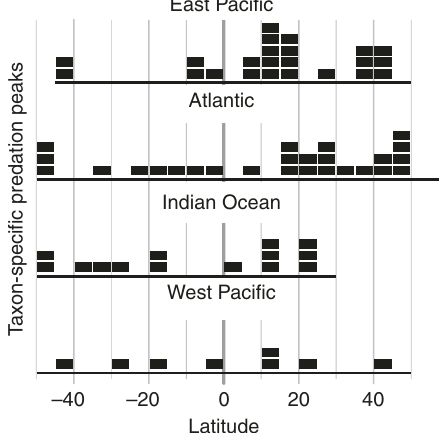
Fig. 3 Distribution of taxon-speci fi c predation peaks across latitude. The latitude where the predation exerted by each predator taxon (i.e., species or groups of related fi sh species) is strongest was calculated based on yearly catch per effort data, separately for each ocean basin. Each black box indicates the latitudinal position of one taxon-speci fi c predation peak (number of taxa: East Paci fi c N = 23, Atlantic N = 26, Indian Ocean N = 14, West Paci fi c N = 8; See Supplementary Fig. 9 and Supplementary Table 3 for detailed taxonomic information). The length of the x -axis indicates the maximal latitudinal extent covered by the available data for each ocean basin. Source data are provided in Supplementary Data 1.